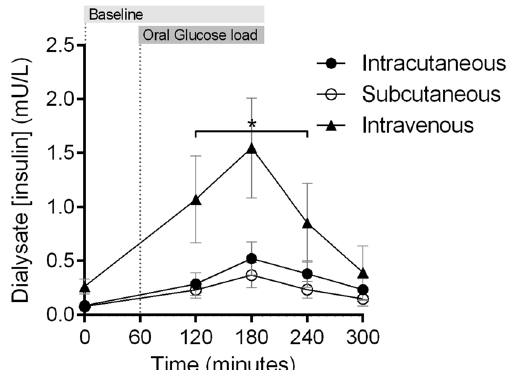
Figure 2. Mean change in dialysate concentration of insulin in the intracutaneous, subcutaneous and intravenous compartment after oral intake of 75 g glucose load in healthy subjects (N = 8). *Indicates a significant difference between the intravenous catheter compared to the intra- and subcutaneous catheters. Error bars represent standard error of the mean